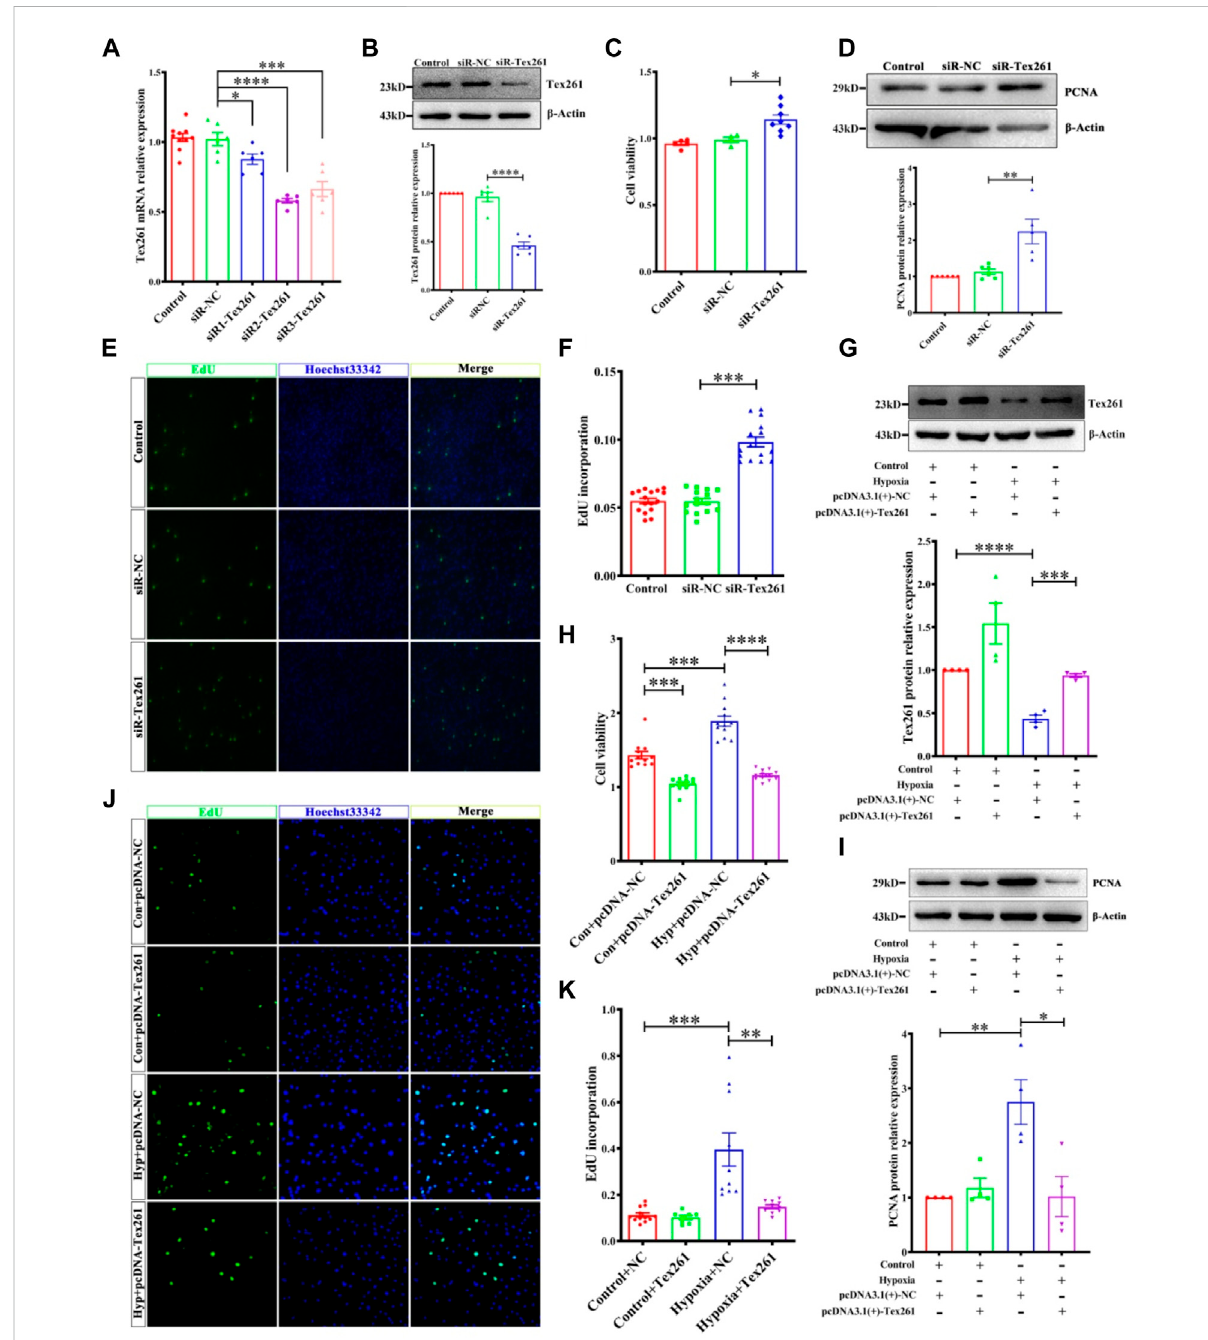
FIGURE 3 Tex261 regulates the proliferation of PASMCs. (A,B) Cell knockdown of Tex261 with siRNAs was veri fi ed in PASMCs ( n = 6). (C) Cell viability was detectedaftertransfectionwithsiR-Tex261orsiR-NCinPASMCsbyMTSassays( n =4 – 8). (D) PCNAexpressionwasmeasuredafterTex261silencing (n=6). (E,F) TheproportionofPASMCproliferationafterTex261silencingwasdetectedbyEdUassaysandobservedby×20magni fi cation( n =6). (G) Western blot results showed Tex261 overexpression by transfection with plasmids in PASMCs ( n = 4). (H) Cell viability was detected after Tex261overexpressionbyMTS. (I) PCNAexpressionwasmeasuredafterTex261overexpression( n =4). (J,K) TheproportionofPASMCsproliferating wasdetected byEdUassays andobserved by×20 microscope. Data are presented asthemean± SEM.* p < 0.05, ** p < 0.01 and*** p < 0.001